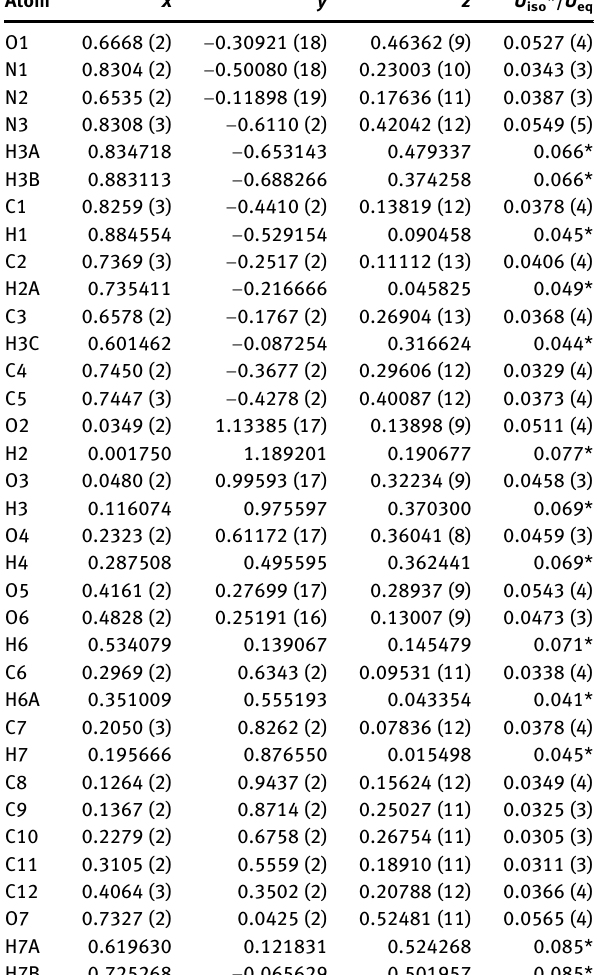
Table  : Fractional atomic coordinates and isotropic or equivalent isotropic displacement parameters (Å 